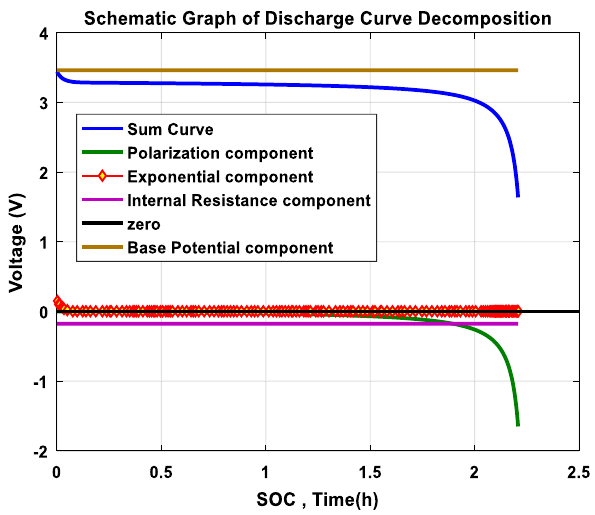
Fig. 5 Schematic graph of the discharge